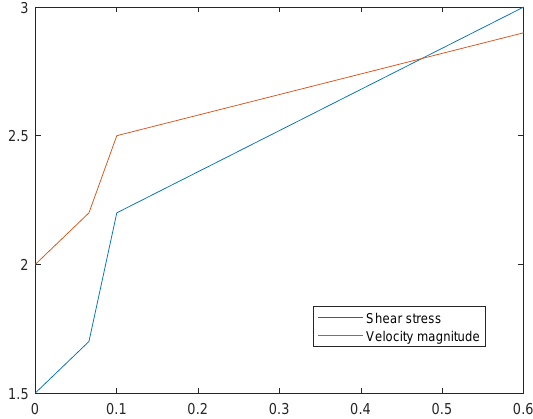
Figure 23. Evolution for shear stress maximum and velocity magnitude maximum by the irregularity